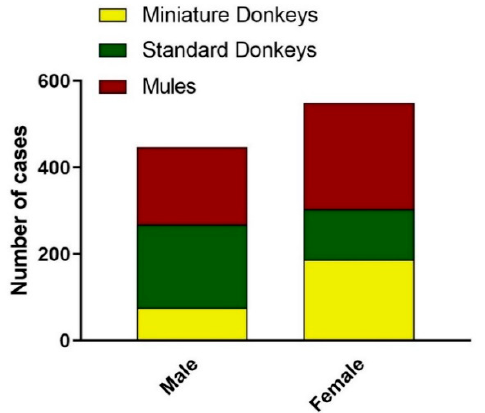
Figure 5. Sex Distribution of Donkey and Mule Caseload from 2008 to 2017. Standard donkeys (green), miniature donkeys (yellow), and mules (red).